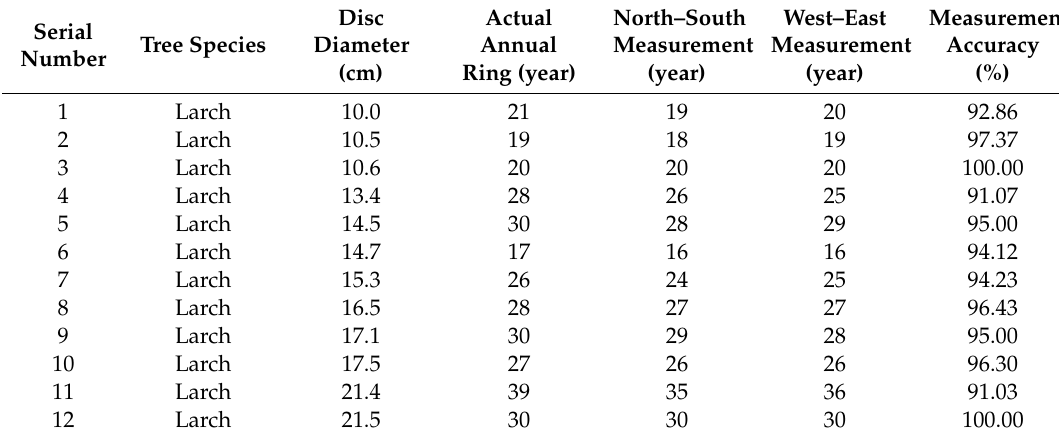
Table 1. The measurement results for larch.